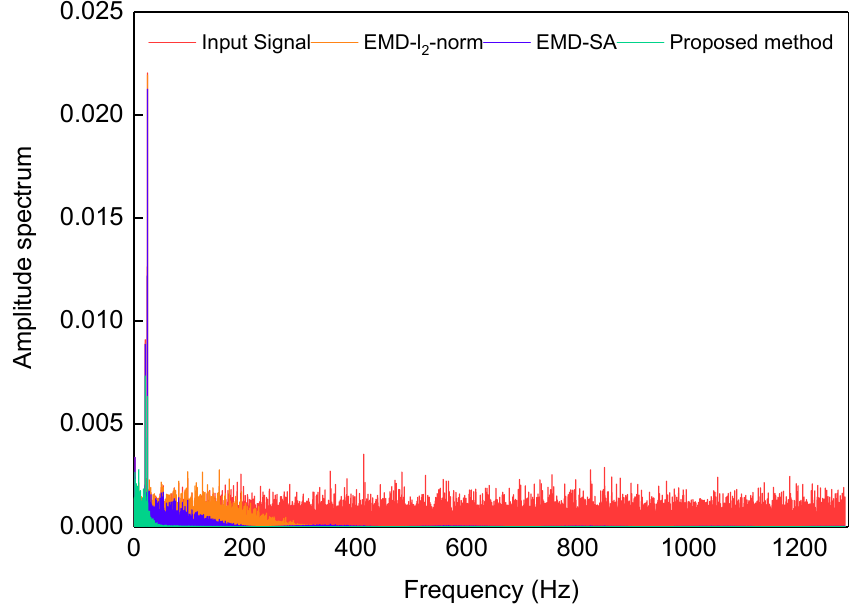
Figure 7. Amplitude spectrum of the signal. The red line is the gyroscope signal; the blue, orange, and green lines are the denoising results of EMD- l 2 -norm, EMD-SA, and the proposed method, respectively.